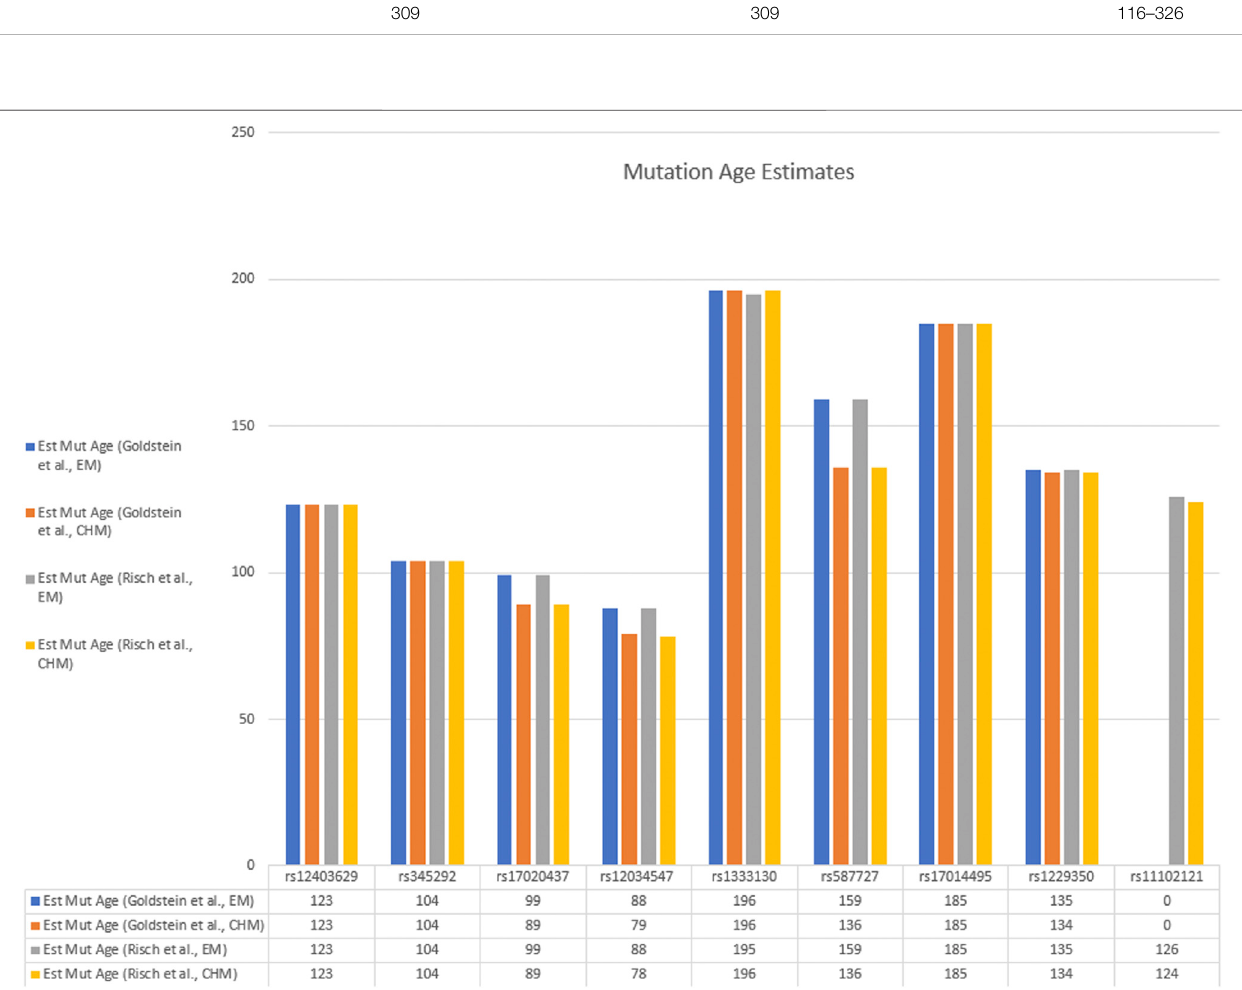
Frontiers in Genetics |